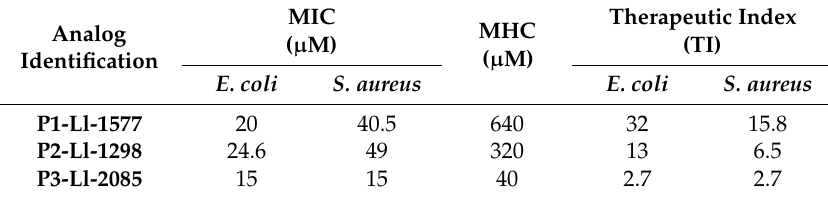
Table 4. Therapeutic index of synthetic peptides.